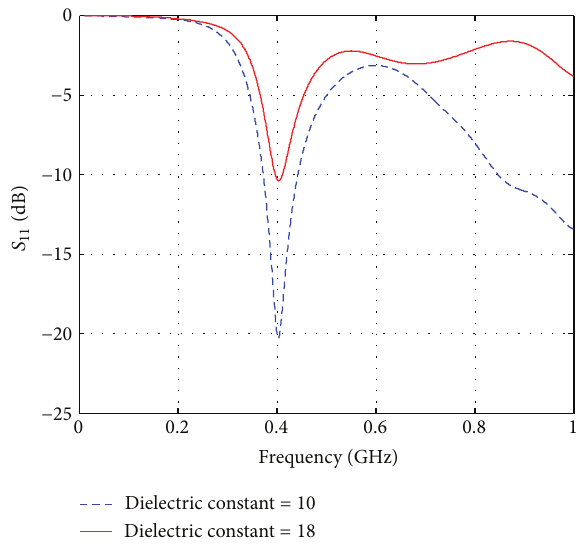
Figure 9: Antenna radiation efficiency with 𝑇 1 = 40 mm, 𝑇 2 = 7 mm at 403 MHz.